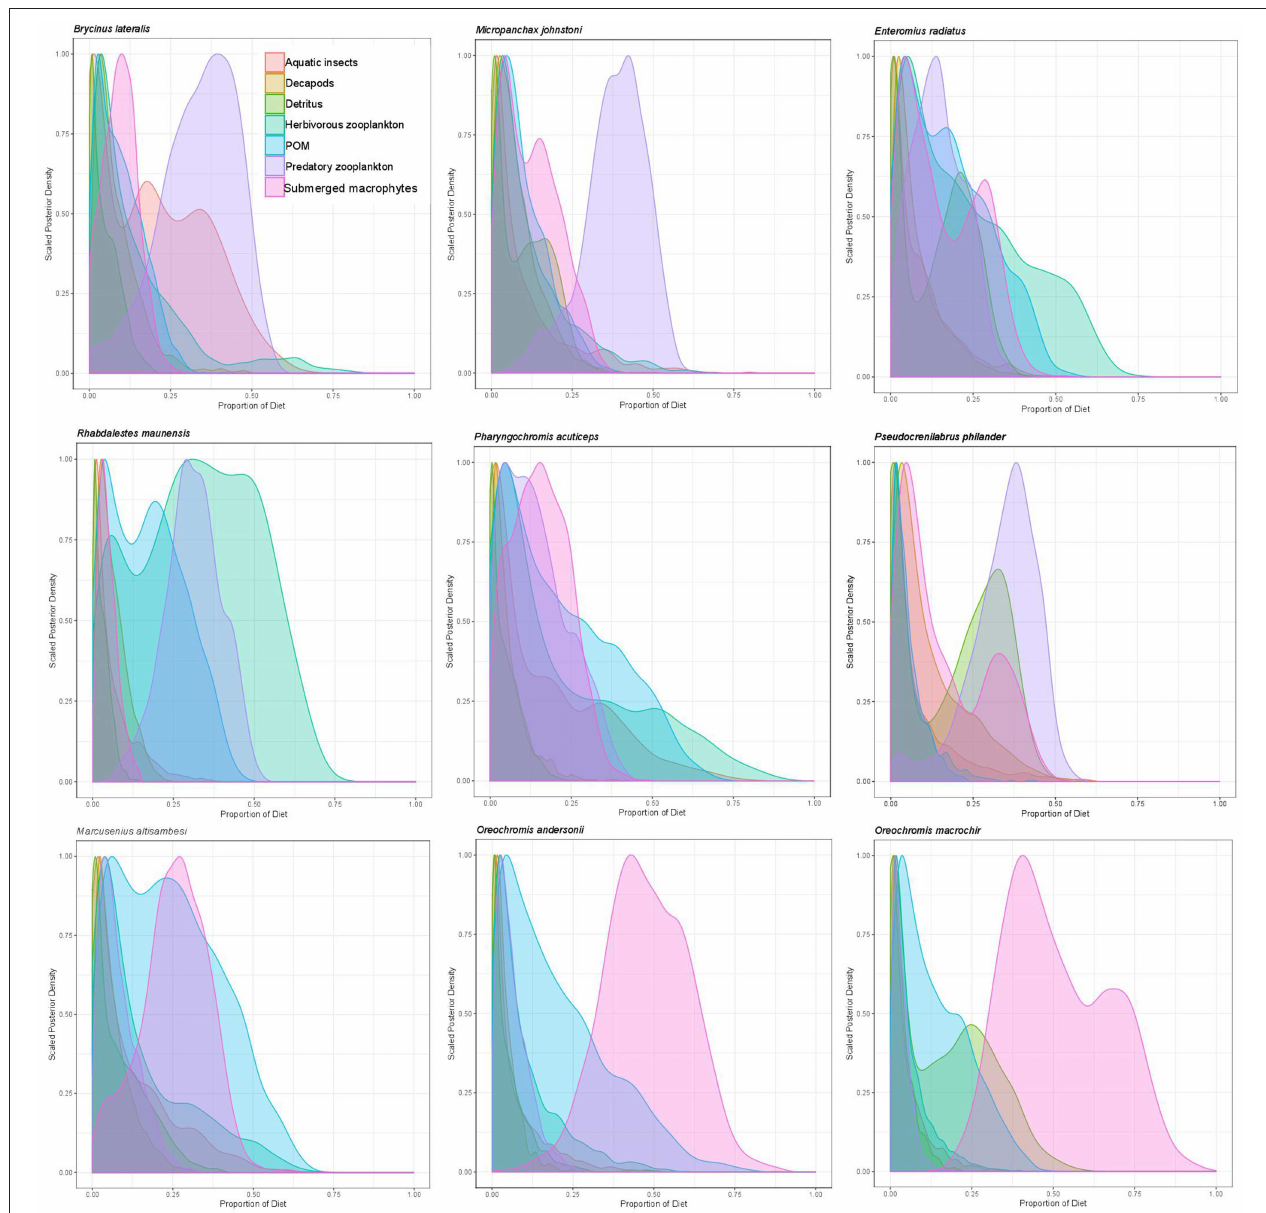
FIGURE 3 | Proportional resource contributions to primary and secondary fish consumers as determined by Bayesian MixSIAR mixing models for